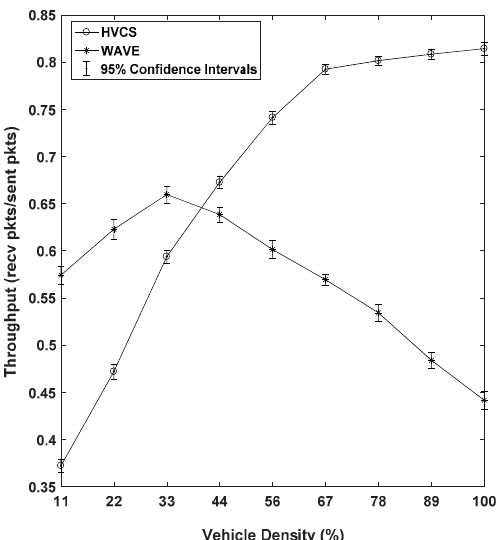
Figure 10. Throughput of the proposed system and the WAVE (the vehicle density was rounded off to the nearest whole